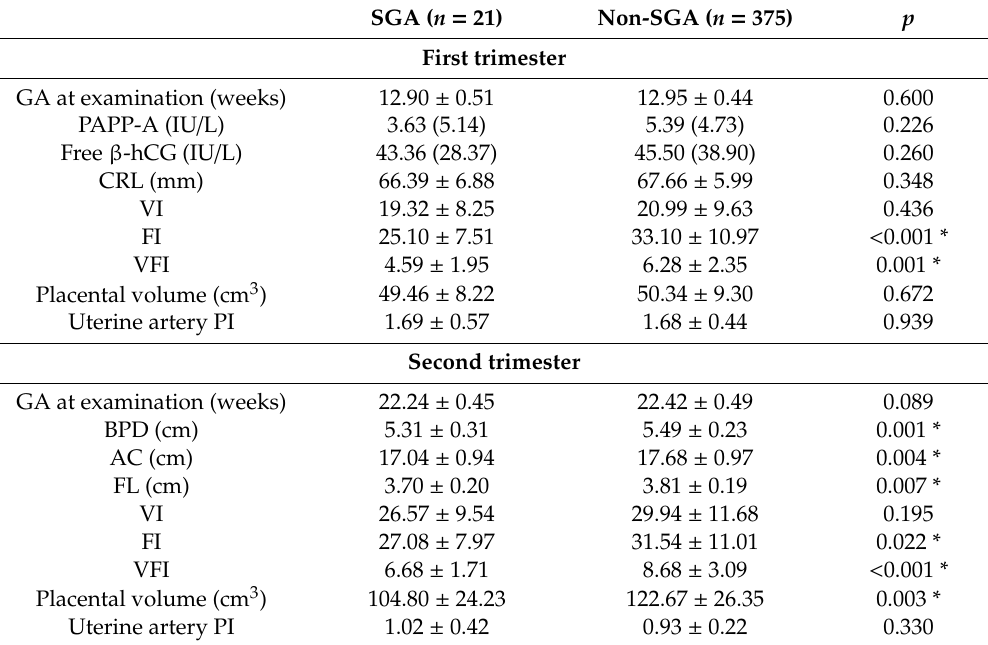
Table 2. Maternal serum markers, fetal biometrics, and results of ultrasound examination between the SGA and non-SGA groups.